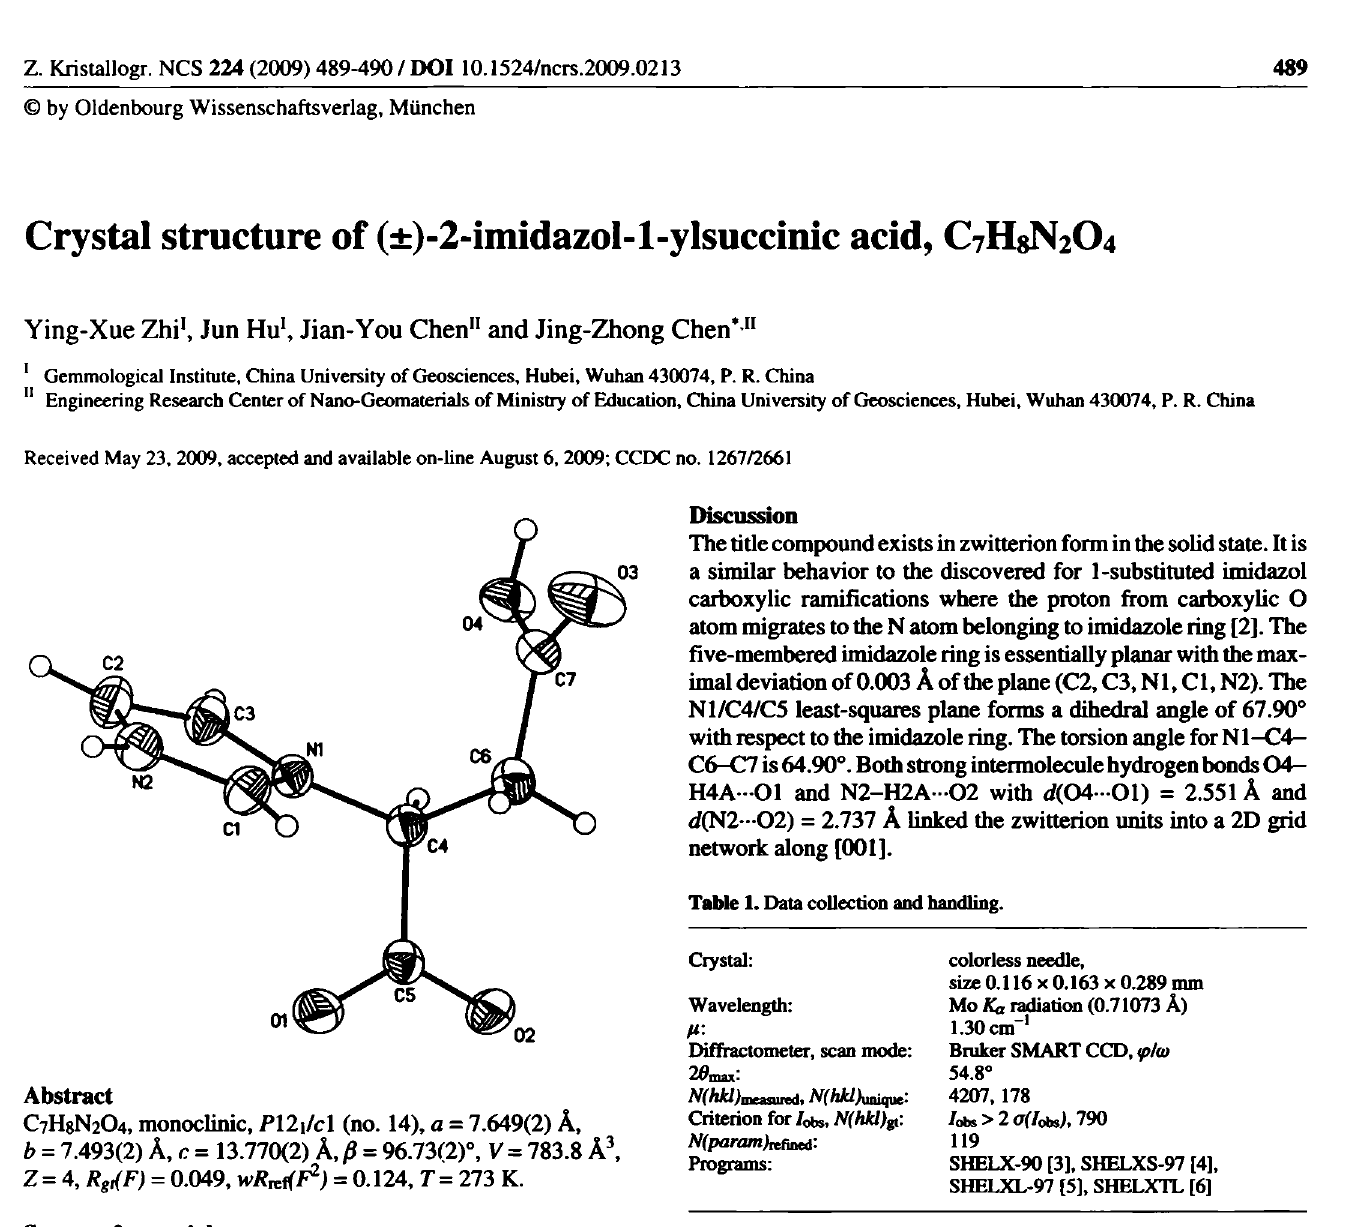
Table 2. Atomic coordinates and displacement parameters (in Â 2